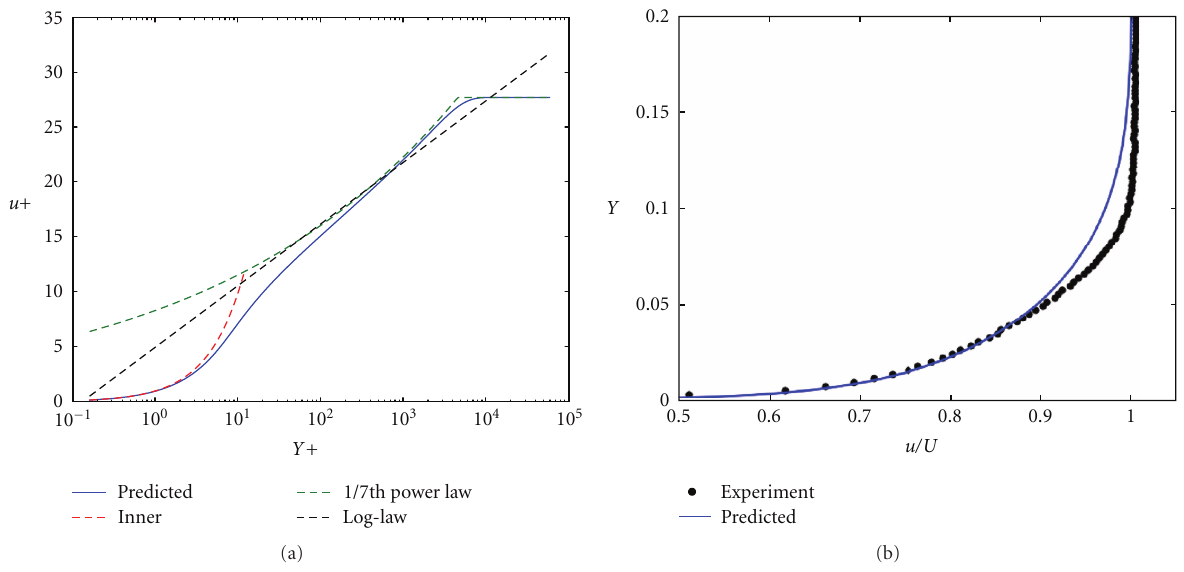
Figure 2: (a) Inflow U -velocity profile in inner-wall coordinates. (b) A turbulent RANS U -velocity profile comparison.